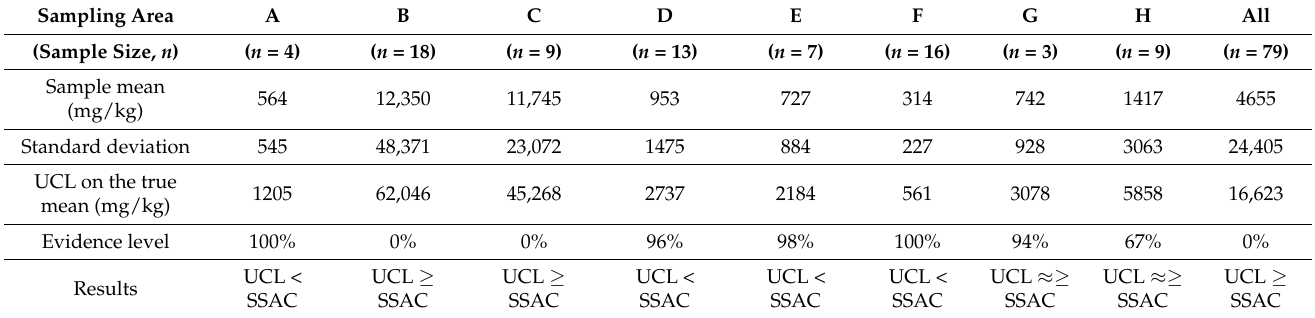
Table 3. Statistical comparison of the soil sample Pb concentrations with the SSAC